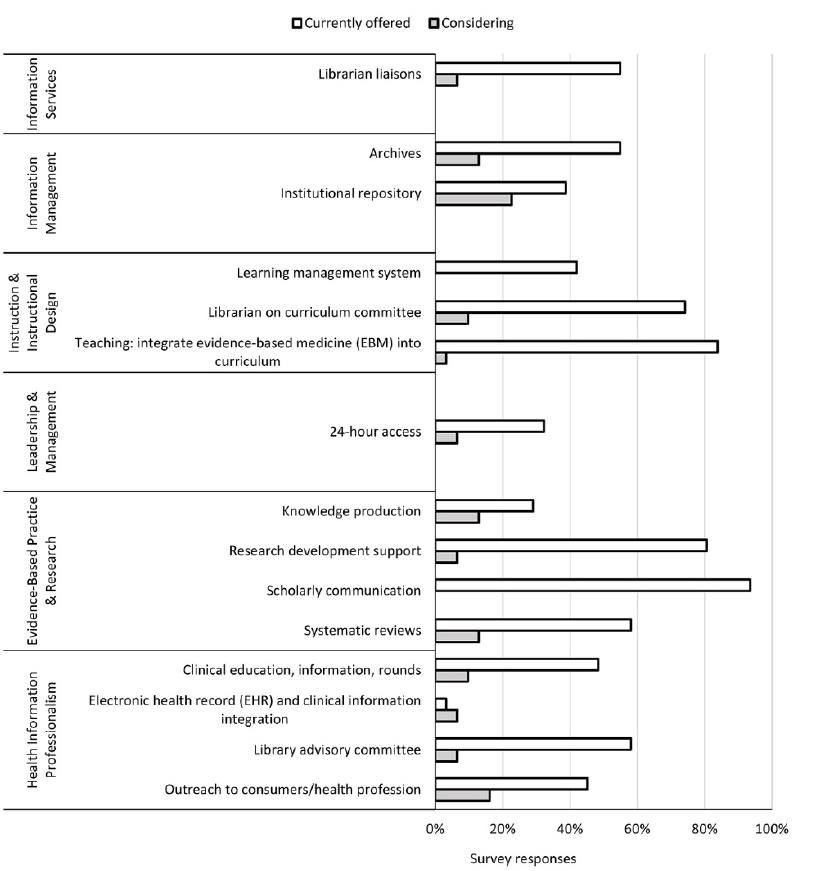
Figure 1 Summary of library services offered and being considered by the responding library directors, grouped by Medical Library Association (MLA)